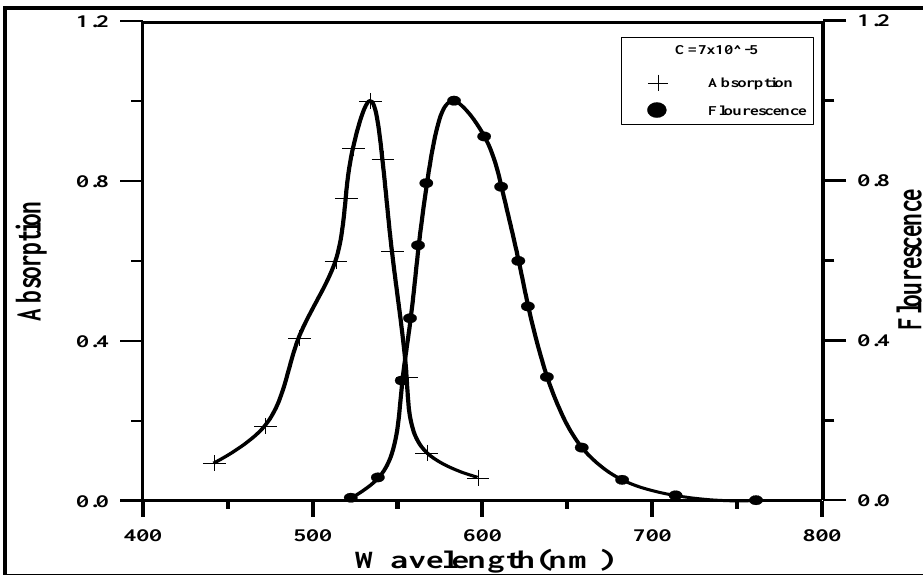
Fig.4: The absorption and fluorescence spectrum of R6G dye doped PMMA for concentration 7×10 -5 mol/ ℓ at thickness (25.8μm).